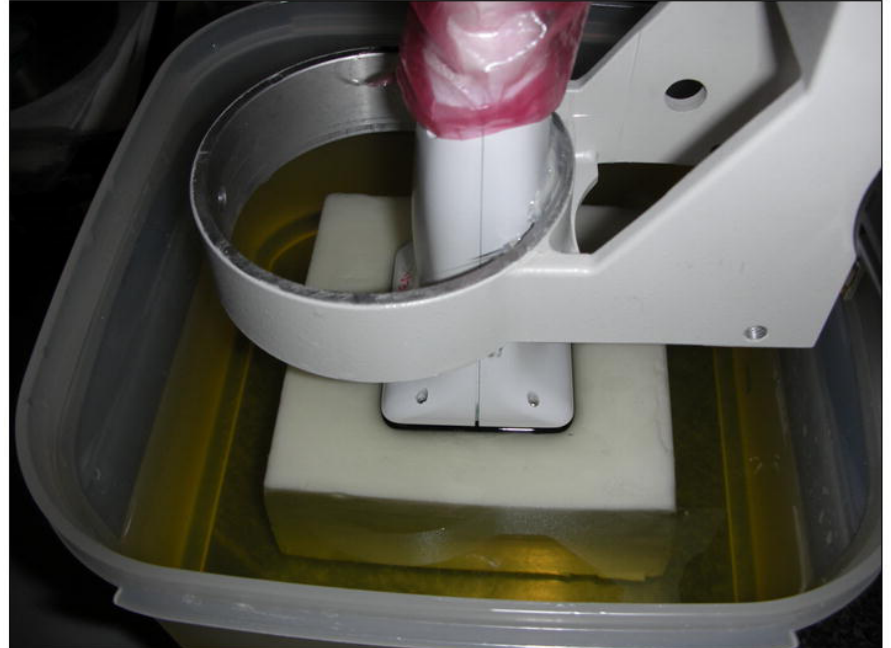
Figure 3. A photograph showing the CMUT ultrasound transducer and the tissue-mimicking